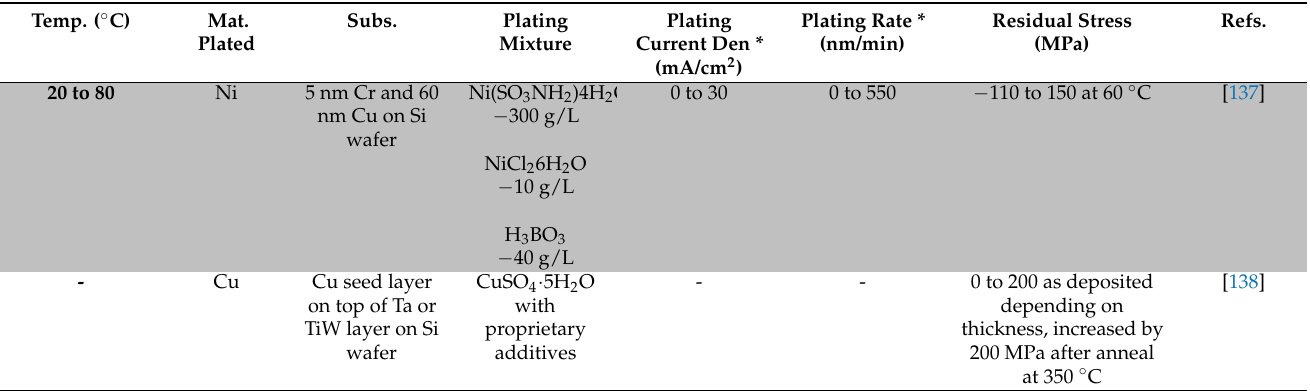
Table 19. Material Properties for Various Electroplated Materials as a Function of Processing